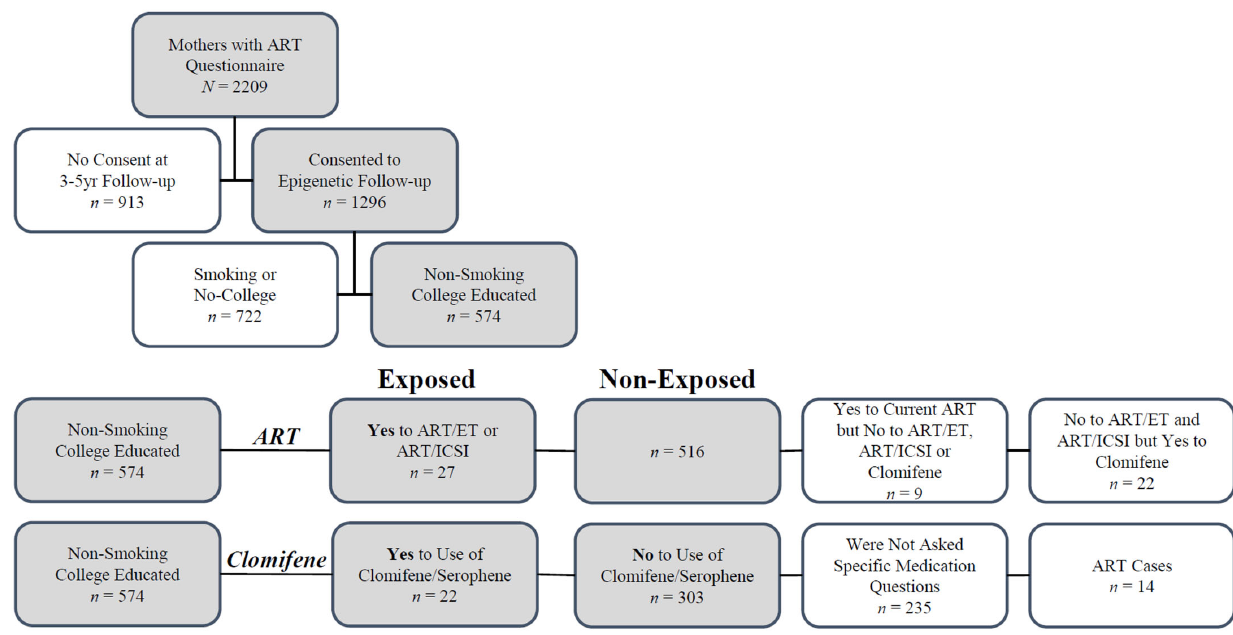
Figure 1. Cohort Selection and Exposed/Non-exposed Definition: Mothers from two waves of en- rollment were asked questions concerning index pregnancy and use of ART use. Of these participants, 1296 mothers agreed to epigenetic follow-up, including pyrosequencing of offspring cord blood. Cases were overwhelmingly non-smoking and college-educated participants; mothers who either smoked or were not college-educated were excluded (removed 5 cases and 717 controls). For the ART-exposed group, 27 cases were defined based on an affirmative answer to either of one of the following questions: “Did you use in vitro fertilization or embryo transfer (IVF/ET)? (Yes, No)”